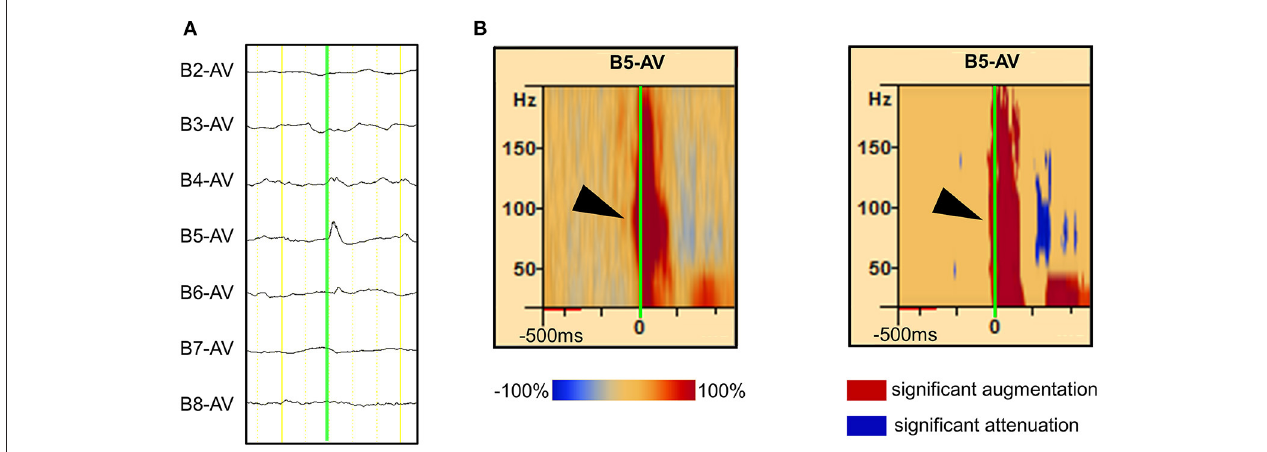
FIGURE 1 | Detection of spike-related high-frequency oscillations (HFOs) using the BESA ® software. (A) The rising edge of the negative spike is marked (green line) in the channel of interest [channel (Ch) B5 is used as an example in this figure]. More than 30 spikes were marked in the same channel. ( B , left) The average HFO augmentation associated with the spikes was analyzed using BESA ® . Within the square, the “percentage augmentation” of the Ch B5 spike-related HFOs relative to the reference (300–500ms prior to the spike, red bar) is shown, ranging from − 100% (blue) to + 100% (red). The earliest HFO augmentation was observed between 80 and 150Hz (arrowhead). ( B , right) The blue color indicates the significant attenuation and the red color indicates the significant augmentation of amplitude in a given time–frequency bin relative to the reference period. The analysis was done using studentized bootstrap statistics. The corrected α level was set to